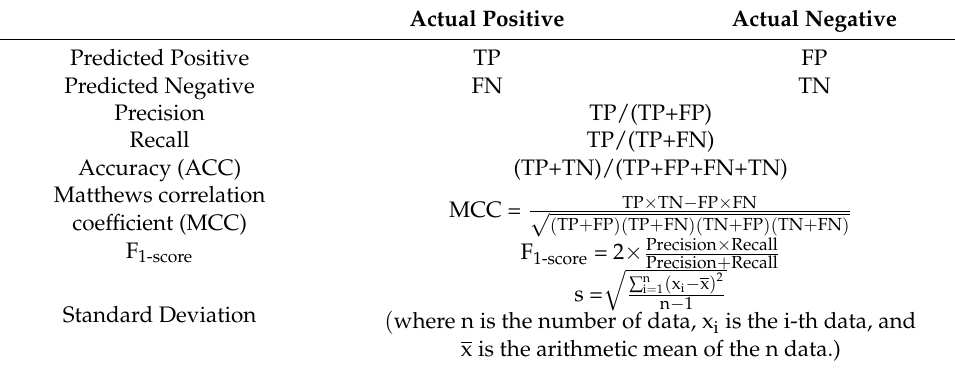
Table 2. Evaluation parameters used in this paper.